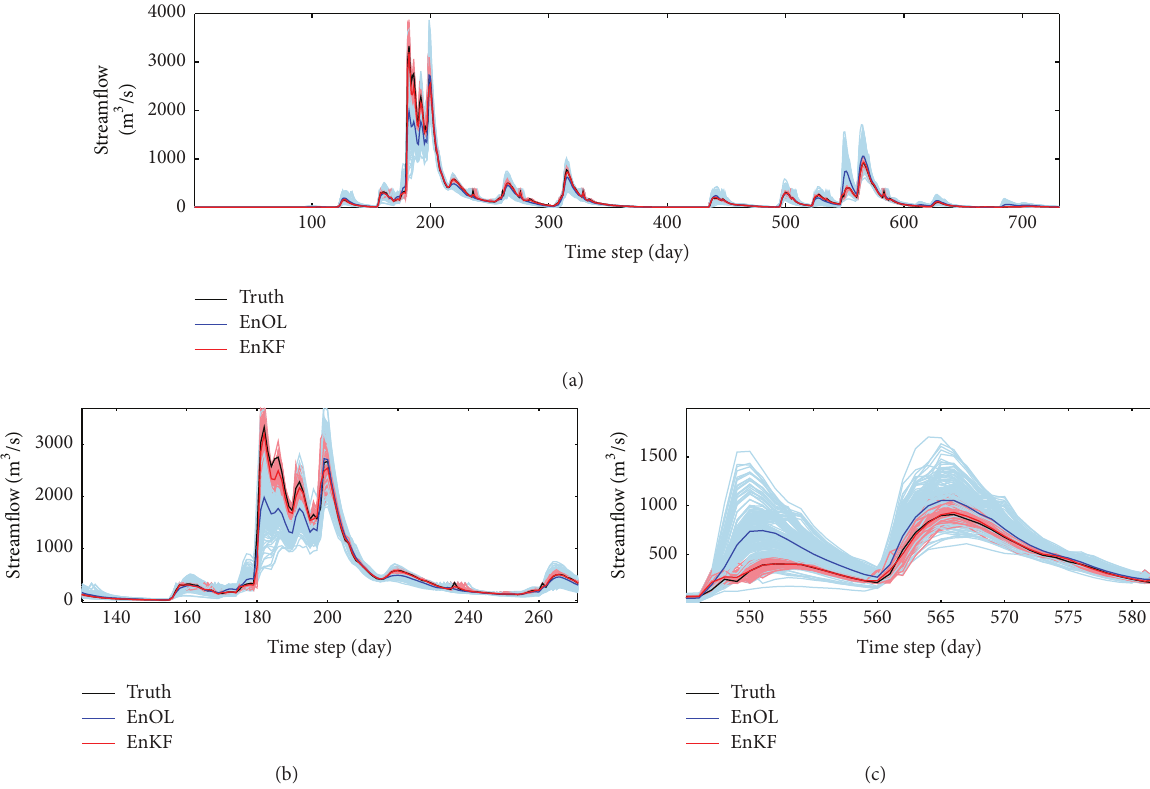
Figure 5: Comparison of the estimated streamflow by EnKF and EnOL at the basin outlet (Huaibin station) in synthetic experiment: (a) the whole period from Jan. 1, 1996 to Dec. 31, 1997; (b) and (c) details of the period with high flows. The light blue and red lines indicate the ensemble members of the EnOL and EnKF, respectively.